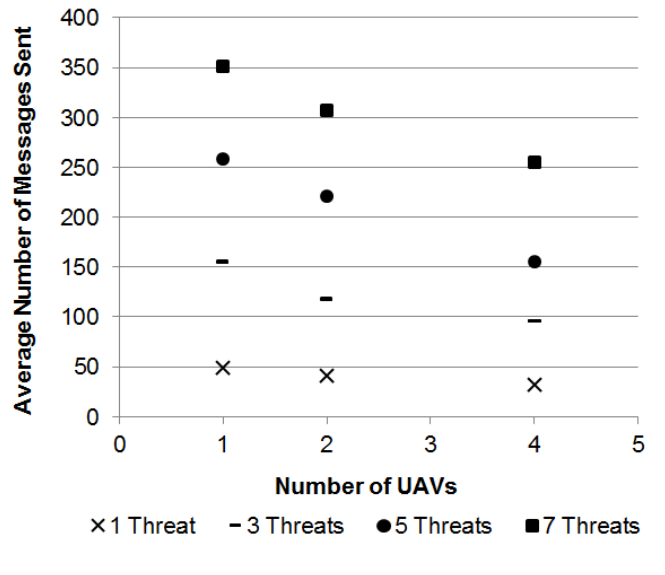
Figure 10. Comparison among the usage of different numbers of Unmanned Aerial Vehicles in terms of number of messages sent for the different setups.